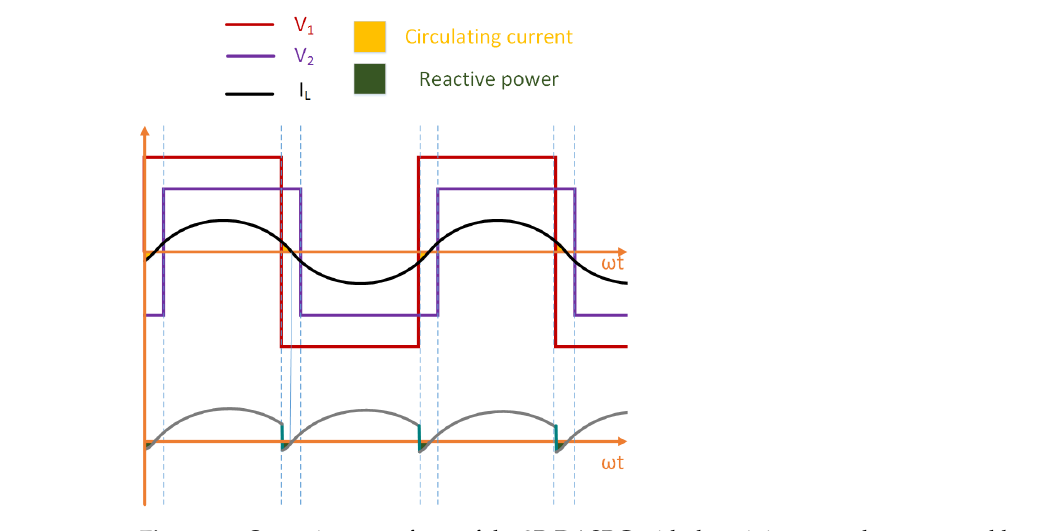
Figure 15. Operation waveform of the 3P-DASRC with the minimum tank current and low reactive power.